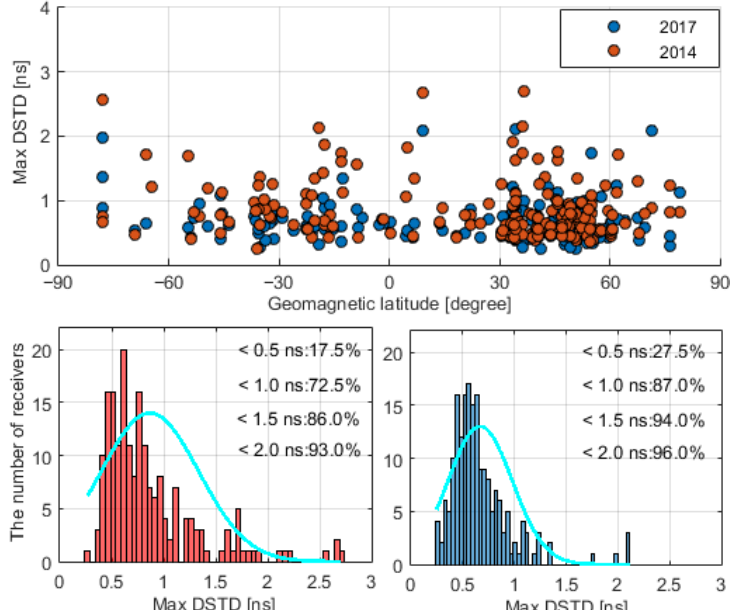
Figure 7. The upper scatter plot displays the maximum DSTD of the estimated receiver DCBs in 2014 and 2017, where the stations are aligned in accordance with their geomagnetic latitudes along the horizontal axis. The bottom histograms show the distribution of the DSTD values, where the vertical axis represents the number of receivers.